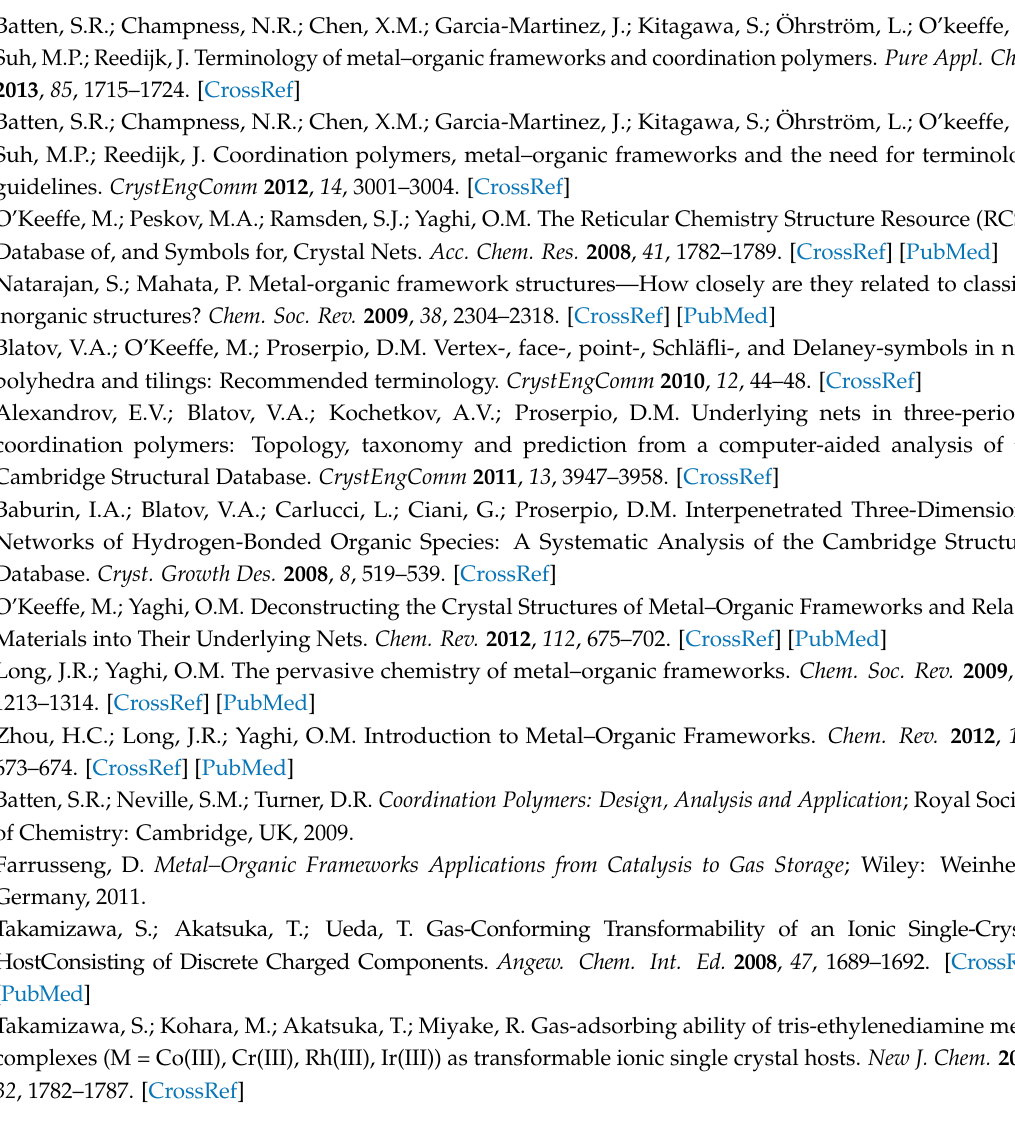
Figure S1: The coordination environments of the Ni(II) ions in (a) [Ni(dpe)(Hbtc)(H 2 O)], A ; (b) [Ni(dpe)(btc)(H 2 O)] − , B ; (c) [Ni(dpe)(btc)(H 2 O) 3 ] − , C ; (d) [Ni(dpe)(H 2 O) 4 ] 2+ , D . ORTEP drawing with 30% thermal ellipsoids. The solvated water molecules and H atoms are omitted for clarity, Table S1: Bond lengths (Å) around Ni(II) ions in 1 , Table S2: The related parameters of O–H . . . O hydrogen bonds for 1 , Table S3: π – π interactions (face-to-face) in 1